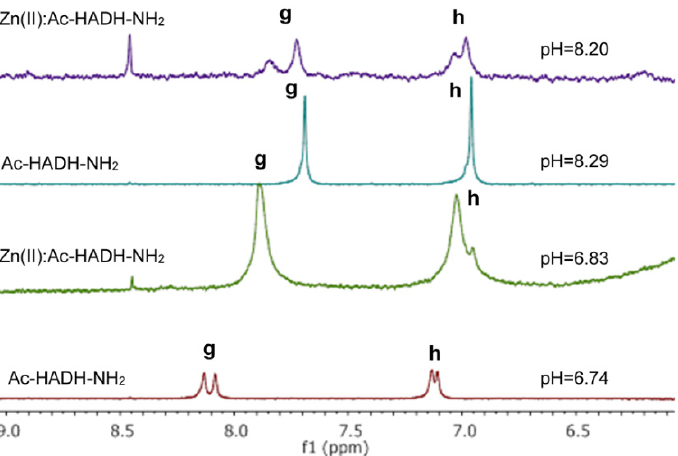
Figure A8. The aromatic region of the pH-dependent 1 H NMR spectra of Ac-HADH-NH 2 and Zn(II)-Ac-HADH-NH 2 = 1.2:1 (c L = 5 mM): g: His (1),(4) H δ ; h: His (1),(4) H ε